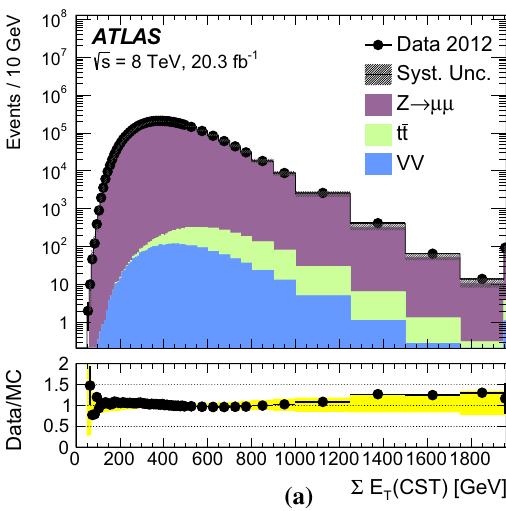
the bands correspond to the combined systematic and MC statistical uncertainties. The far right bin includes the integral of all events with (cid:5) E T above 2000 GeV